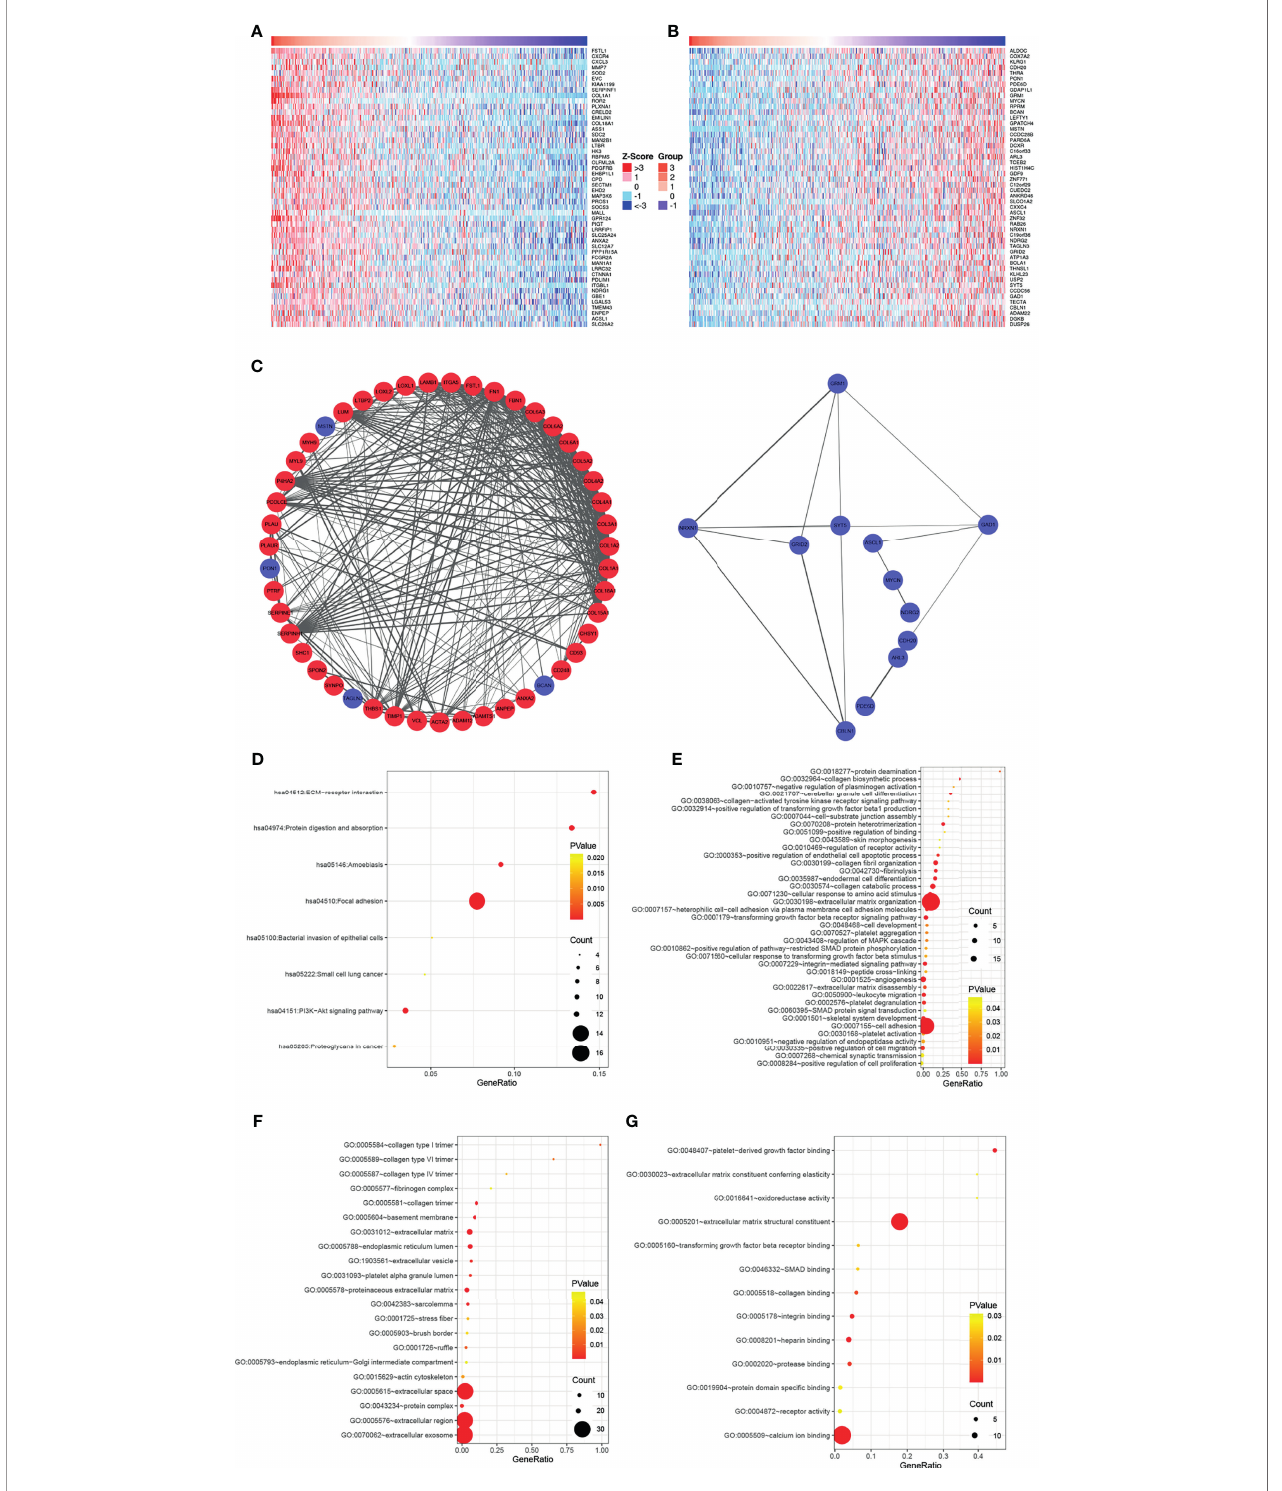
FIGURE 3 | COL5A1 co-expressed genes and function enrichment analysis based on them. (A, B) Heatmaps showing the top 50 genes positively or negatively correlated with COL5A1; red and blue represent positively and negatively associated genes, respectively. (C) The networks of genes positively and negatively correlated with COL5A1. (D – G) . Functional enrichment analysis of the selected 100 genes; bubble plots represent signi fi cantly enriched terms in KEGG pathways and GO categories (p < 0.05) (BP, biological processes; CC, cell component; MF, molecular